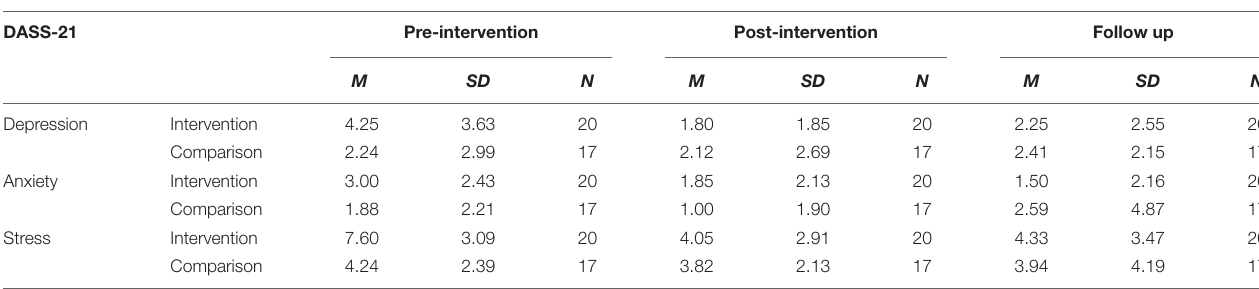
FIGURE 1 | PSI-SF total score, parental distress and difficult child marginal pre, post, and follow-up means. TABLE 2 | DASS-21 means and standard deviation